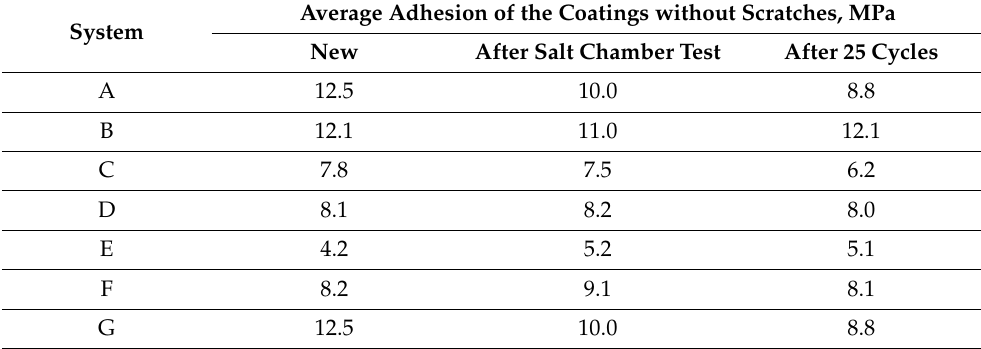
Table 7. Coating adhesion before and after salt spray tests according to ISO 16276-2:2007 [28]. System